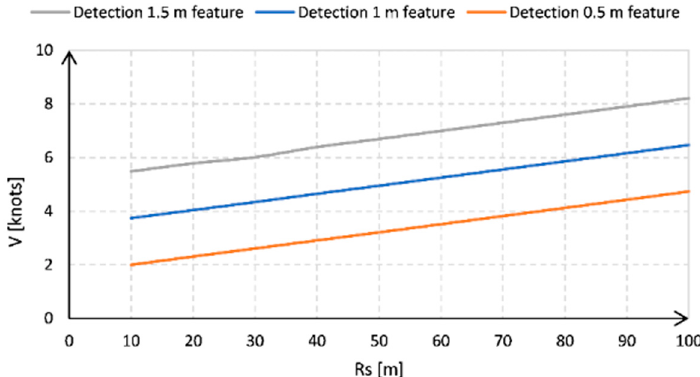
Figure 8. Maximum sonar towing speeds as a function of detection distance for objects of three different lengths for the sonar operation range R = 100 m; (high resolution channel f = 500 kHz; sound speed c = 1430 m/s; horizontal beamwidth θ h = 0.5 °).